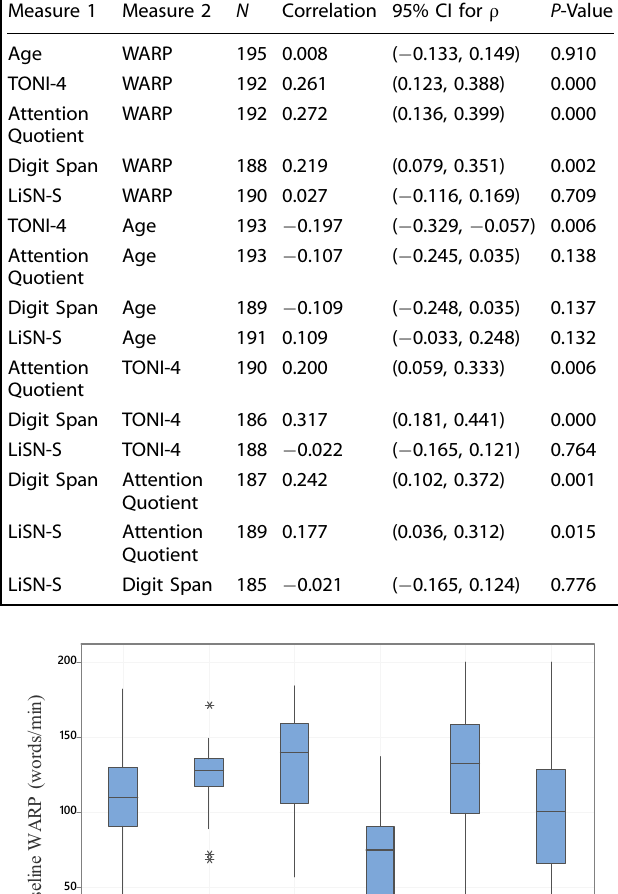
Table 1. Pairwise Pearson Correlations showing the associations between baseline measures.